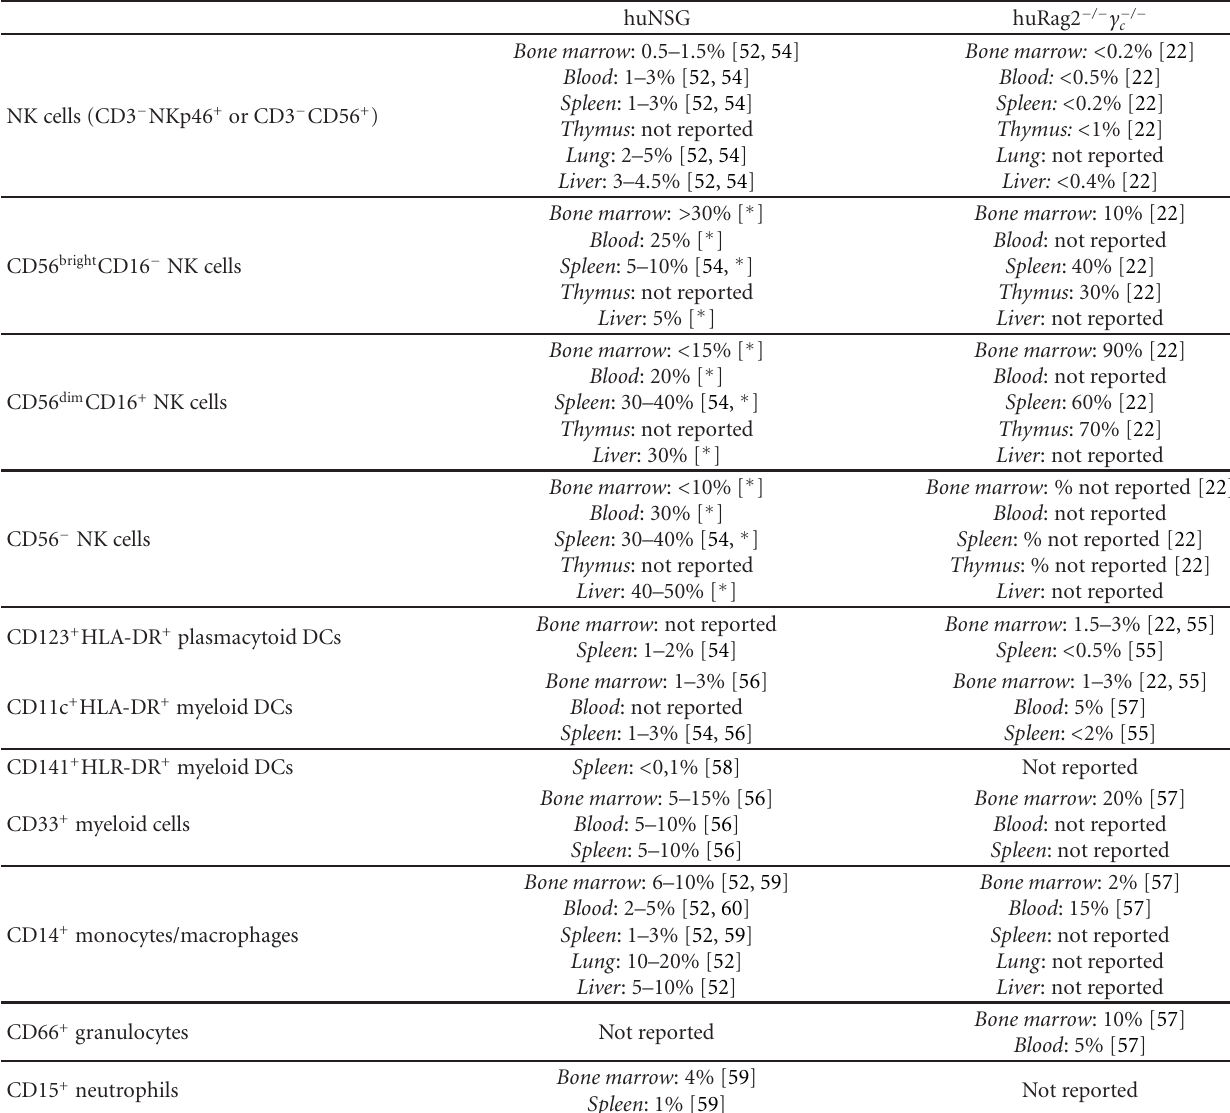
Table 1: Distribution and frequencies of NK cells, NK-cell subsets, and myeloid cells in mice with reconstituted human immune system components. Only data from two mouse model systems of human immune system reconstitution are shown. Frequency of NK-cell subsets relates to total NK cells. In vivo administrationof humancytokines is reported to lead to up to tenfold increases in targeted cell compartments [22, 52]. ∗ Chijioke et al., unpublished. huNSG huRag2 − / − γ − / − c